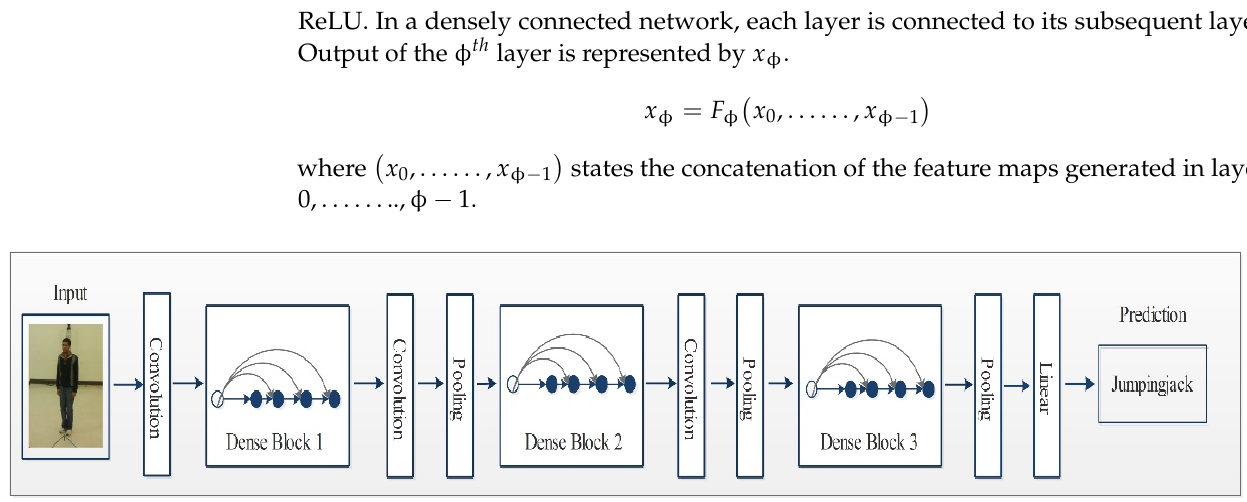
Figure 3. Network architecture of DenseNet201 for action recognition.